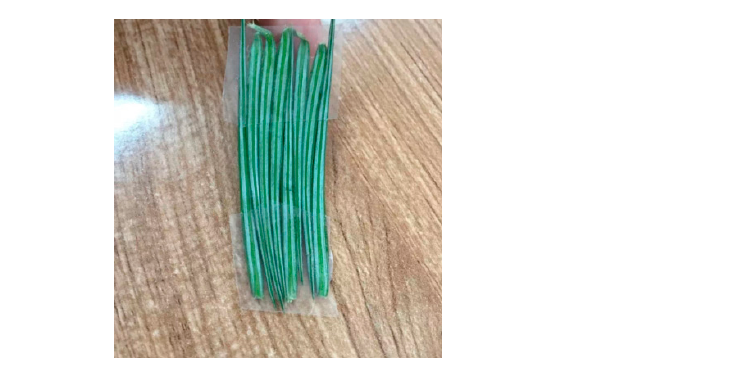
Table origin: [50].